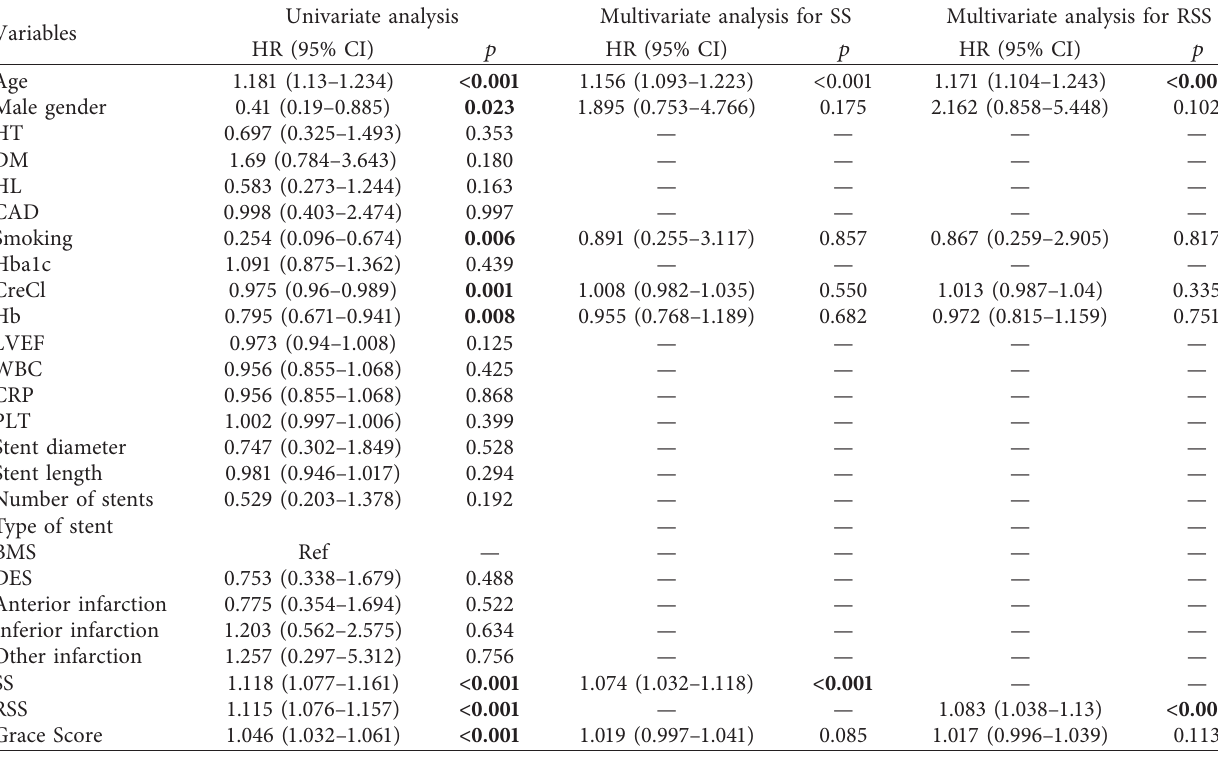
Table 5: Univariate and multivariate cox regression analysis for determining the risk factors associated with long-term cardiac death. Univariate analysis Multivariate analysis for SS Multivariate analysis for Variables